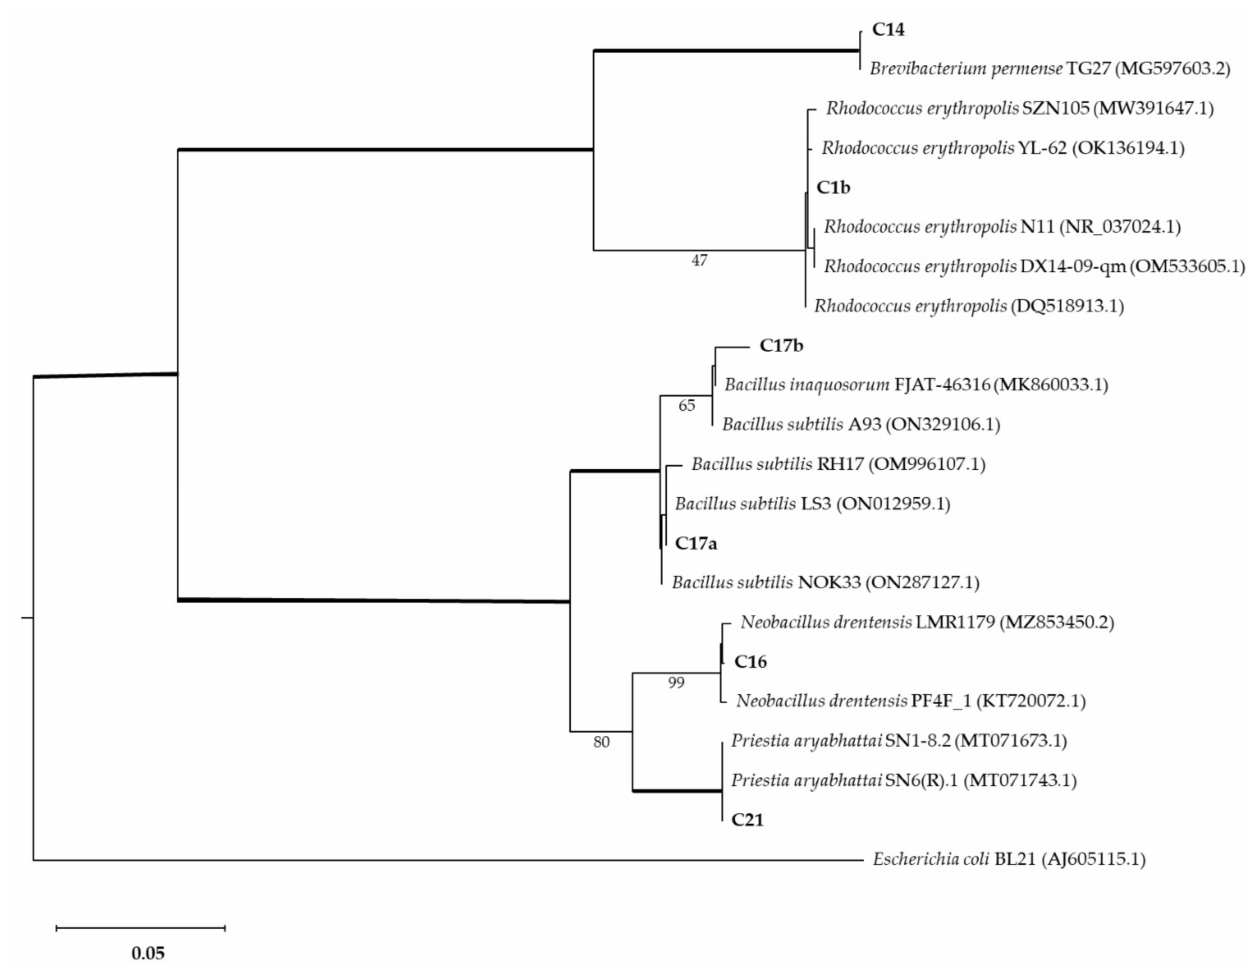
Figure 5. Phylogenetic analysis of bacterial isolates compared with other isolates (GenBank accession numbers shown in brackets). The Maximum Likelihood method was used with a bootstrap consensus tree (from 1000 replicates to represent the distance). Escherichia coli BL21 was introduced as an outgroup. Number of substitutions per nucleotide site for a unit of branch length is given in the scale bar